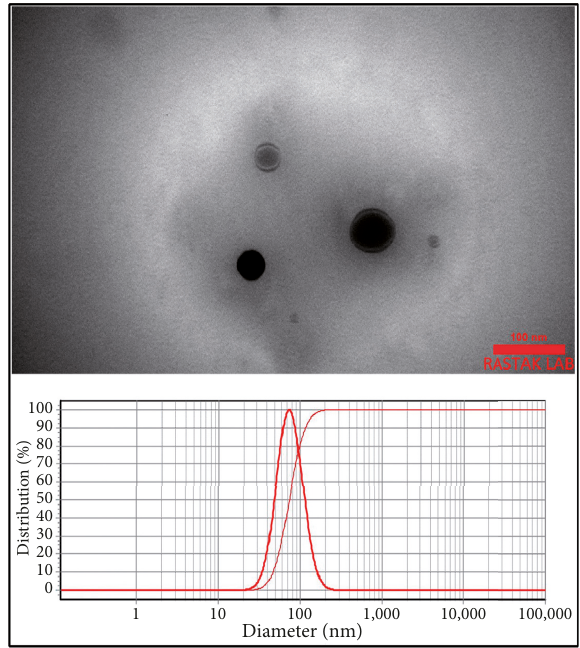
Figure 2: TEM and DLS analyses of nanoliposomes containing the 0.5% C. zeylanicum EO with a particle size of 119 ± 6nm (SPAN 0.98).